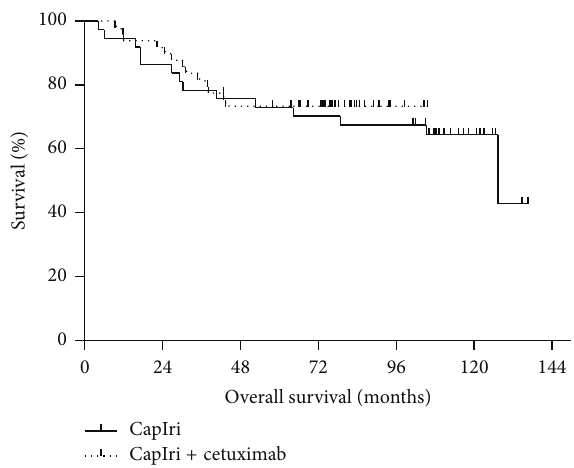
Figure 3: Overall survival of patients with locally advanced rec- tal cancer receiving capecitabine/irinotecan +/ − cetuximab based chemoradiotherapy as preoperative treatment ( 𝑛 = 86 ). Shown are survival curves of patients treated with CapIri (solid curve; 𝑛 = 49 ) versuspatientswithKRASWTreceivingCapIri+cetuximab(dotted curve; 𝑛 = 32 ), 𝑃 = 0.39